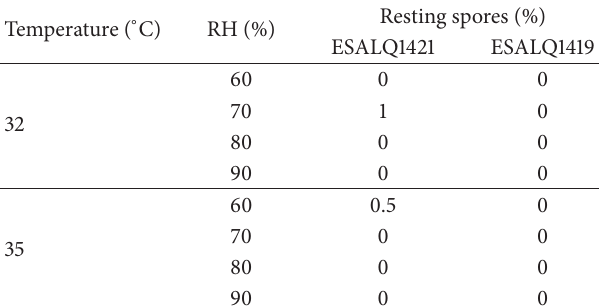
Table 2: Effect of different combinations of abiotic factors (tem- perature and RH) on resting spores produced in N. floridana killed T. evansi by two isolates from Brazil (ESALQ1419 and ESALQ1421).